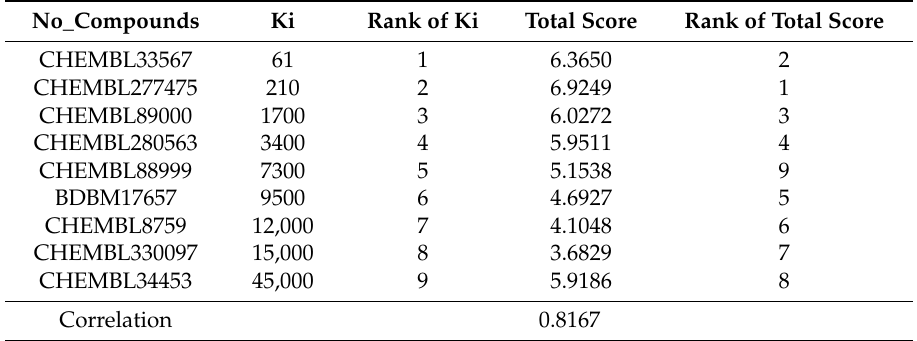
Table 7. The data of correlation between the rank of compounds experimental affinity (Ki) and docking score of mGluR8.